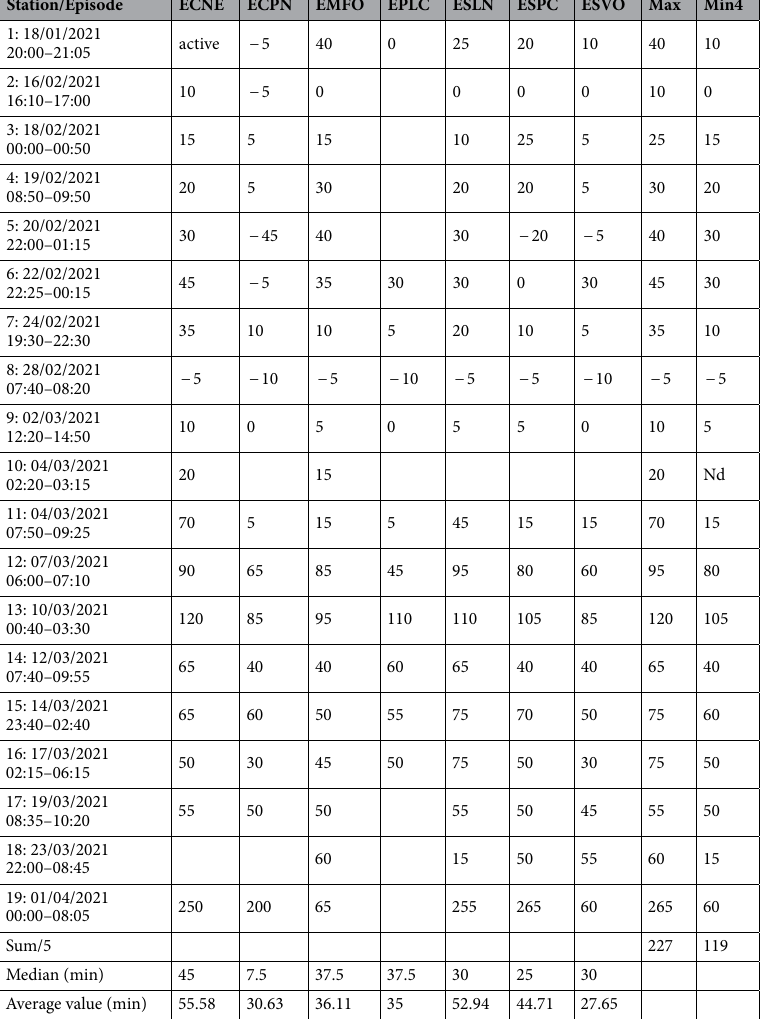
Table 4. Lead times calculated from the appearance of cluster